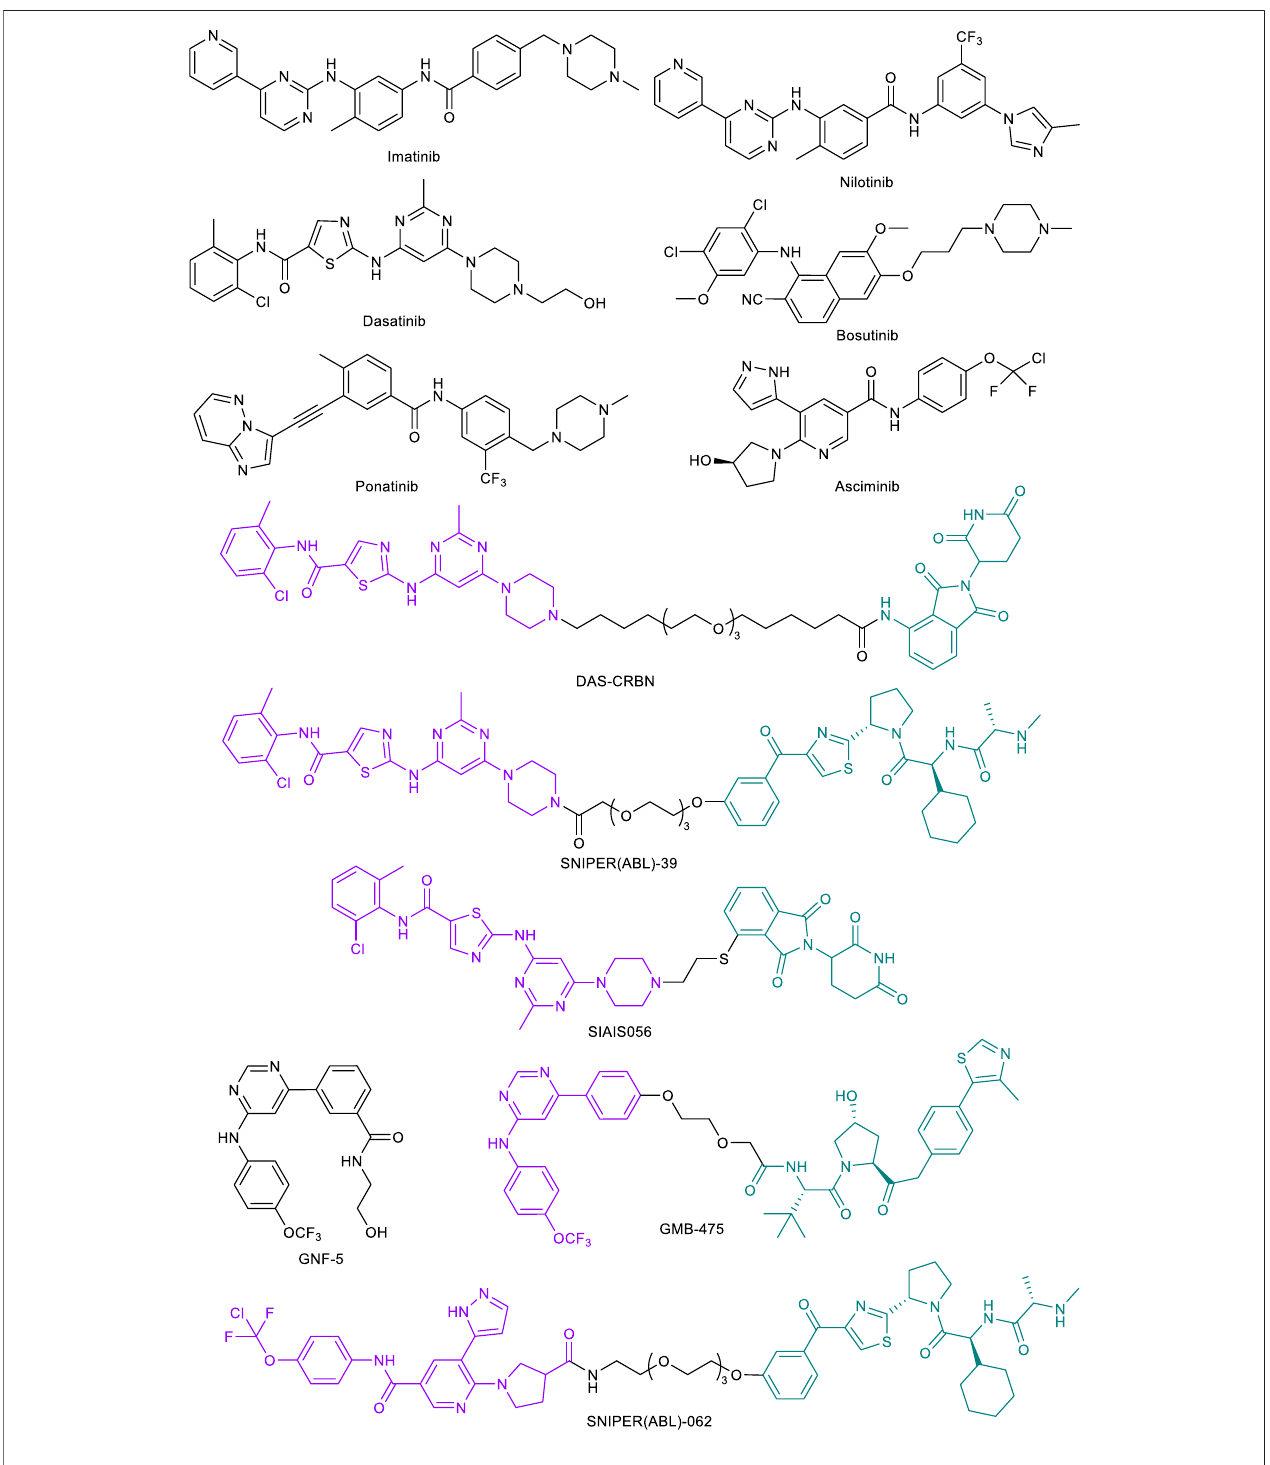
FIGURE 2 | Key BCR-ABL1 small molecule inhibitors and BCR-ABL1-targeted PROTACs.